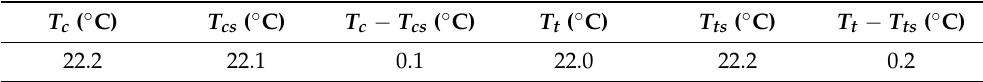
Table 3. Comparison of the thermographic temperature measurement T c , the surface temperature of the capacitor obtained as a result of the simulation work T cs , the temperature measured with a thermocouple T t , and the temperature obtained as a result of the simulation work for the location of the thermocouple T ts .